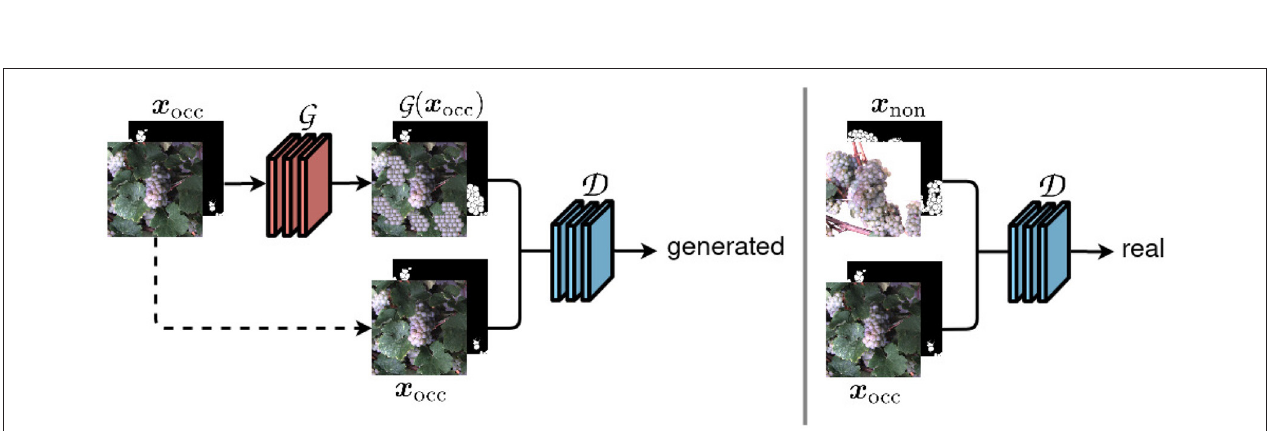
FIGURE 2 | Our network structure based on the Pix2Pix framework (Isola et al., 2017). An input image x occ of the occluded domain is transferred to a non-occluded domain using a generator network G . The discriminator network D distinguish whether the output of G looks real or generated.